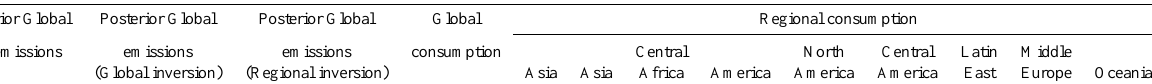
Table 2. Prior and Posterior Global Total Emissions and Annual Global/Regional Consumption of HCFC-22 (Ggyr − 1 ). Consumption data is taken from UNEP (2011).